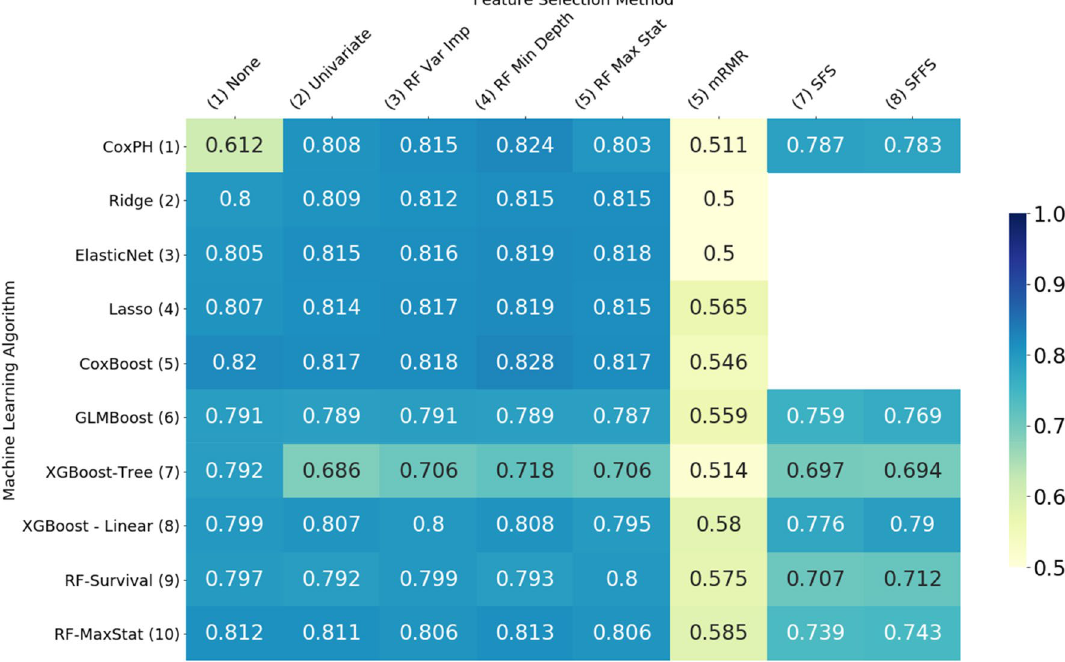
Figure 1. Heatmap illustrating the performance of each of the machine learning algorithms with each feature selection method on the MAS dataset, measured by the mean concordance